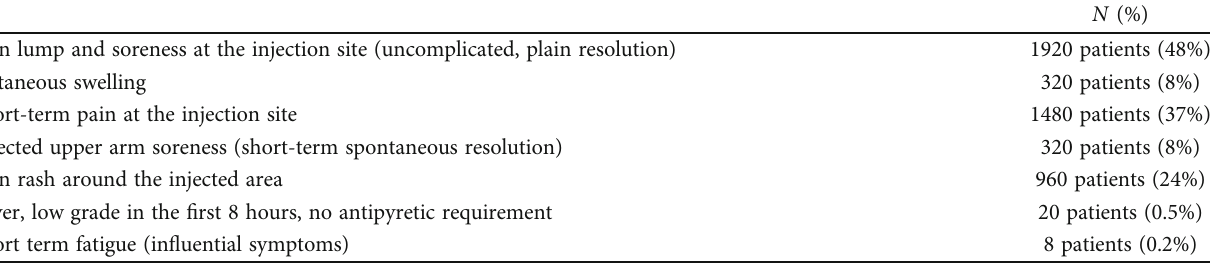
Skin lump and soreness at the injection site (uncomplicated, plain resolution)